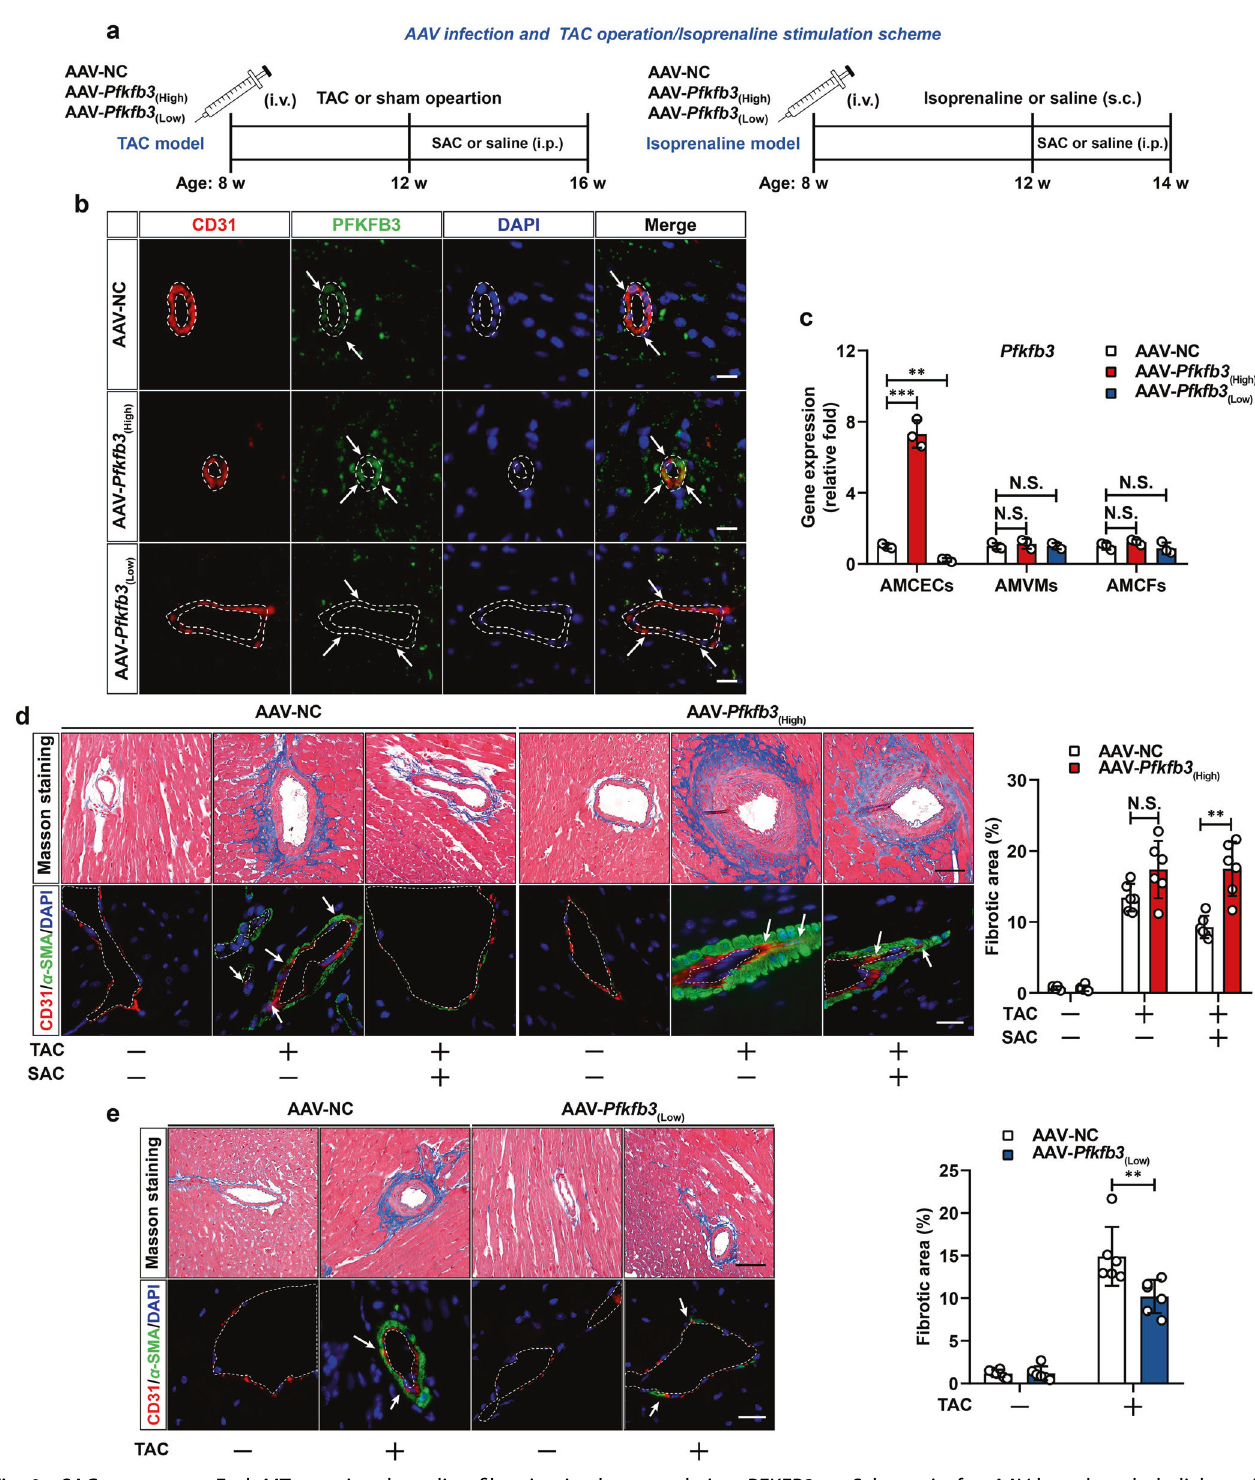
Fig. 8 SAC attenuates EndoMT-associated cardiac fi brosis via downregulating PFKFB3. a Schematic for AAV-based endothelial-speci fi c overexpression or knockdown of Pfkfb3 and model preparation procedure in mice. b Immuno fl uorescent counter-staining of PFKFB3 (Green) and CD31 (Red) in cardiac sections (white dotted line was applied to delineate the inner surface of blood vessel) from AAV-NC, AAV- Pfkfb3 (High) , and AAV- Pfkfb3 (Low) mice, scale bar, 25 μ m. c q-PCR analysis of Pfkfb3 mRNA level in AMCECs, AMVMs and AMCFs isolated from AAV-NC, AAV- Pfkfb3 (High) , and AAV- Pfkfb3 (Low) mice. 18s RNA was used as the internal reference ( n = 3). d Masson and immuno fl uorescent double-staining of CD31 (Red) and α -SMA (Green) of cardiac sections (white dotted line was applied to delineate the inner surface of blood vessel) from AAV-NC or AAV- Pfkfb3 (High) infected mice post sham-operation, TAC-operation, and SAC-treatment, scale bar, 50 μ m ( n = 6). e Masson staining and immuno fl uorescent double-staining of CD31 (Red) and α -SMA (Green) of cardiac sections (white dotted line was applied to delineate the inner surface of blood vessel) from AAV-NC and AAV- Pfkfb3 (Low) mice post-sham-operation, TAC-operation and SAC- treatment, scale bar, 50 μ m ( n = 6). Data are represented as mean ± SD. ** p < 0.01, *** p < 0.001, N.S., nonsigni fi cant versus indicated group